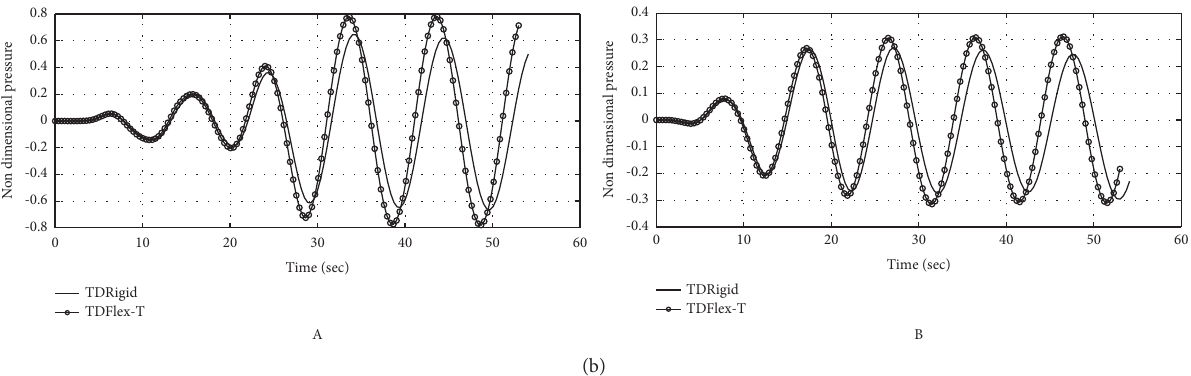
Figure 18: (a) Pressure time history of S175 hull at bow region, F 1). (B) Pressure on bottom surface (see Figure 17; location point 4). (b) Pressure time history of ULC at bow region, F Pressure at free surface (Figure 17; location point 1). (B) Pressure at bottom surface (Figure 17; location point 4).